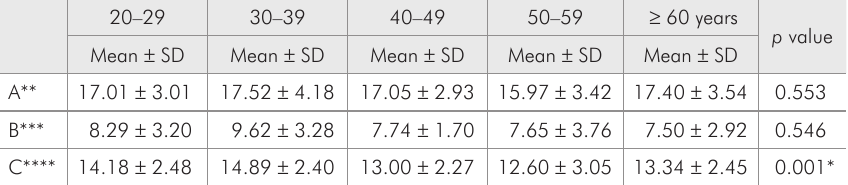
Table 3 - Measurements according to age